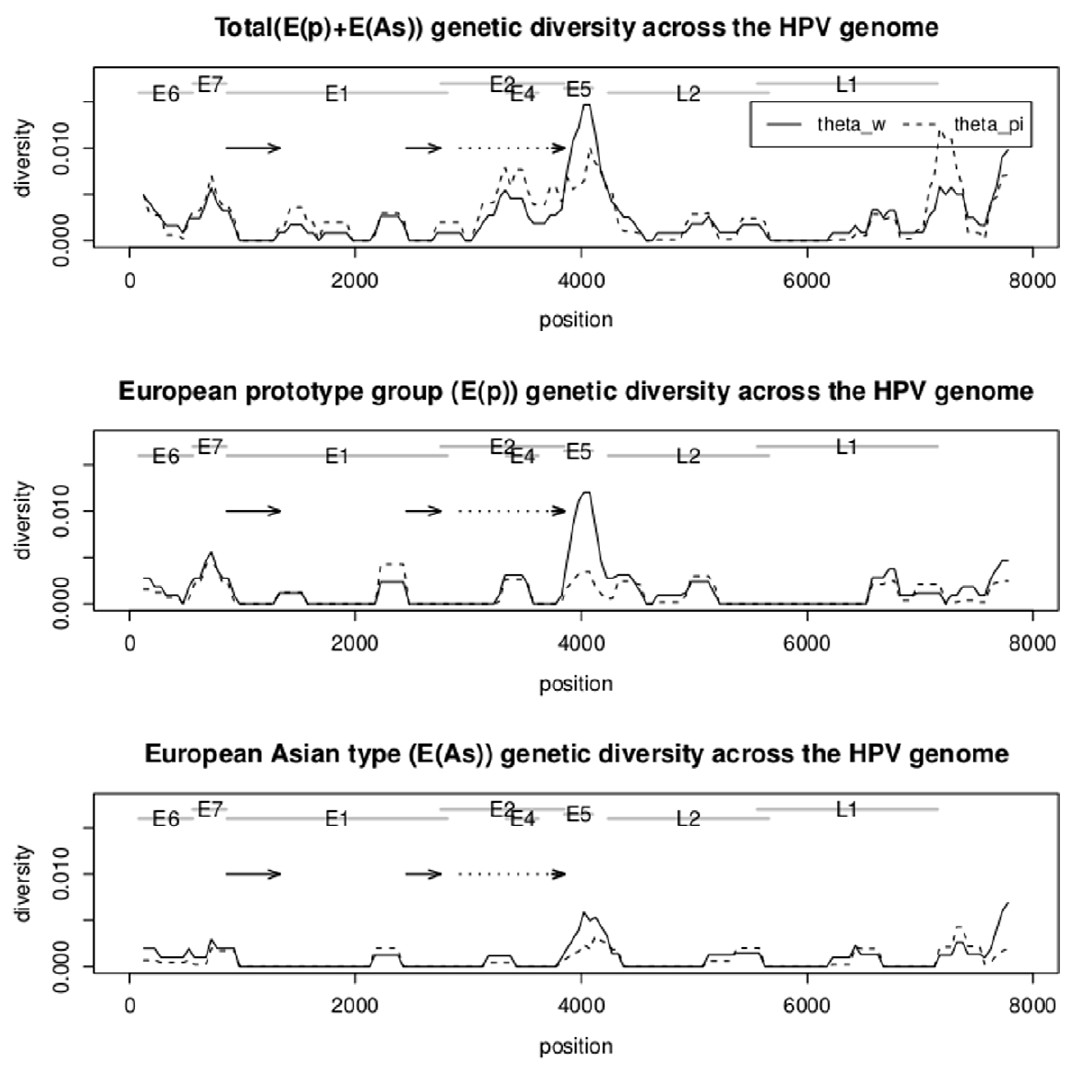
Figure 2. Sliding window plot of genetic diversity across the HPV genome. Window size is set as 250 bp and step size=50 bp. The solid arrows indicate the two regions in the E1 gene that failed in the PCR reactions. The dashed arrow indicates the region in E2 gene that failed in some of the specimens. Theta_w is the Watternson’s estimate of genetic diversity which is based on the number of polymorphic sites [43], and theta_piis the Tajima’s estimate of genetic diversity relying on average pairwise differences